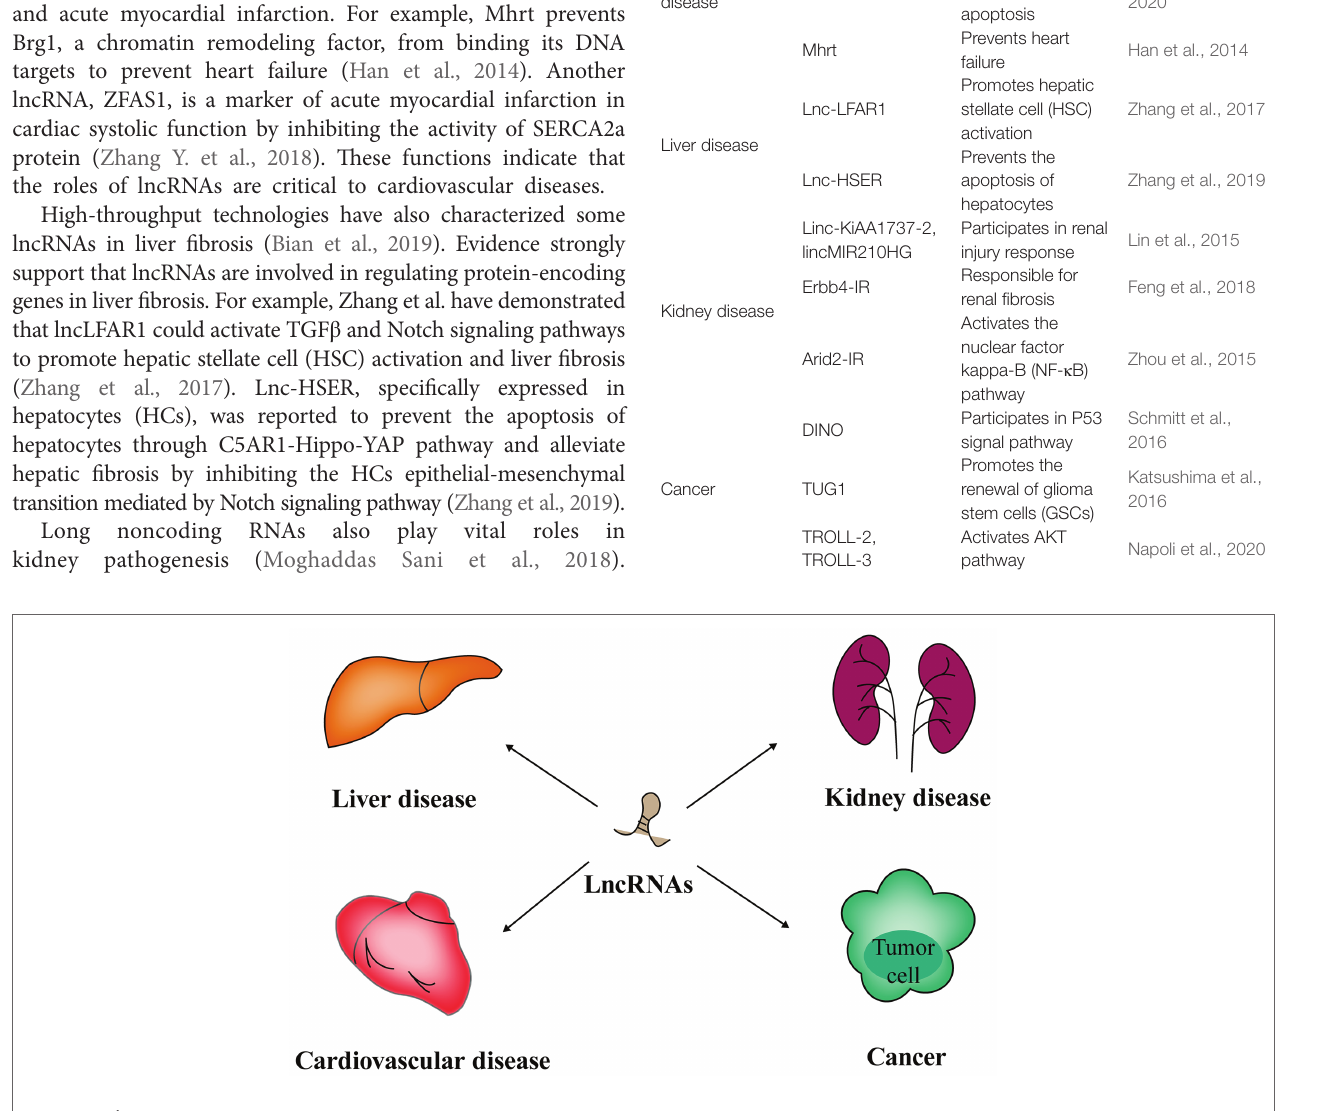
FIGURE 2 | Long noncoding RNAs play critical roles in the pathogenesis of cardiovascular, liver, and kidney disease as well as cancers.